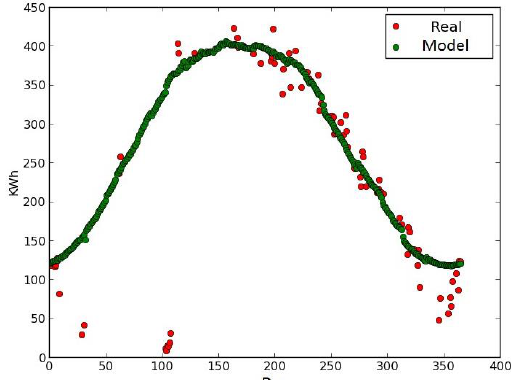
Figure 5: Estimated and real (measured) energy production on the plant used for the model validation.